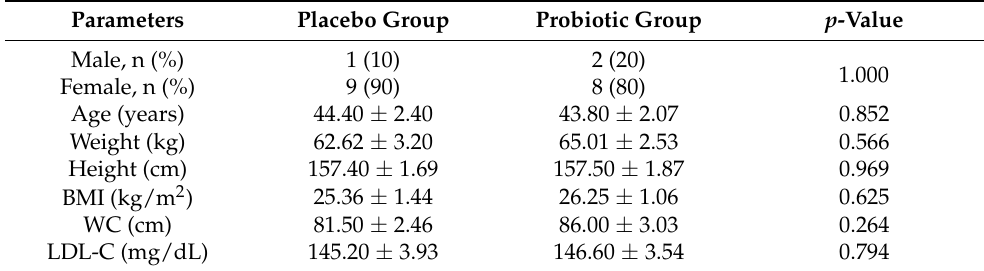
Table 3. General demographic characteristics of the participants.